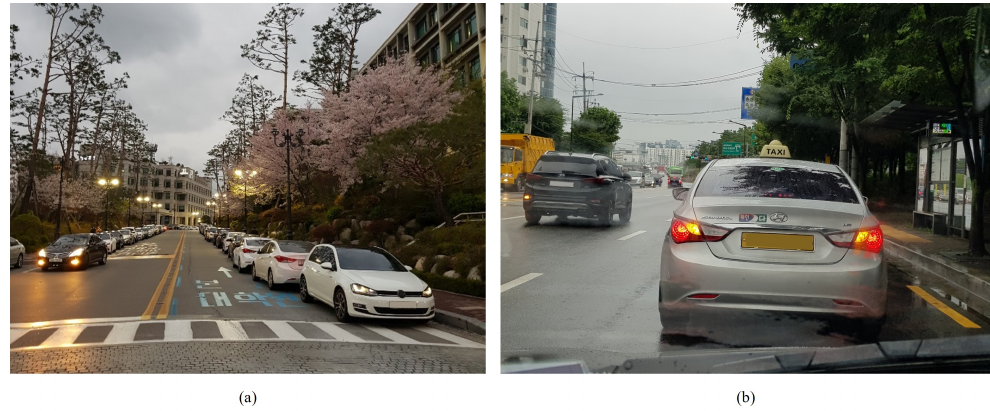
Figure 3. Stationary vehicles on road: ( a ) Illegally parked vehicles; ( b ) Stationary vehicle with an unpredictable